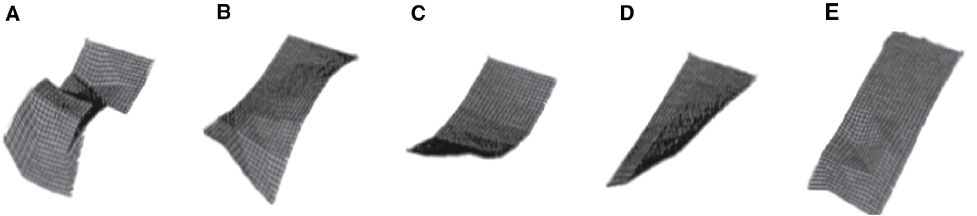
Figure 4: Different resonance modes by modal analysis (no hole specimen). (A) First mode (B) second mode (C) third mode (D) fourth mode (E) fifth